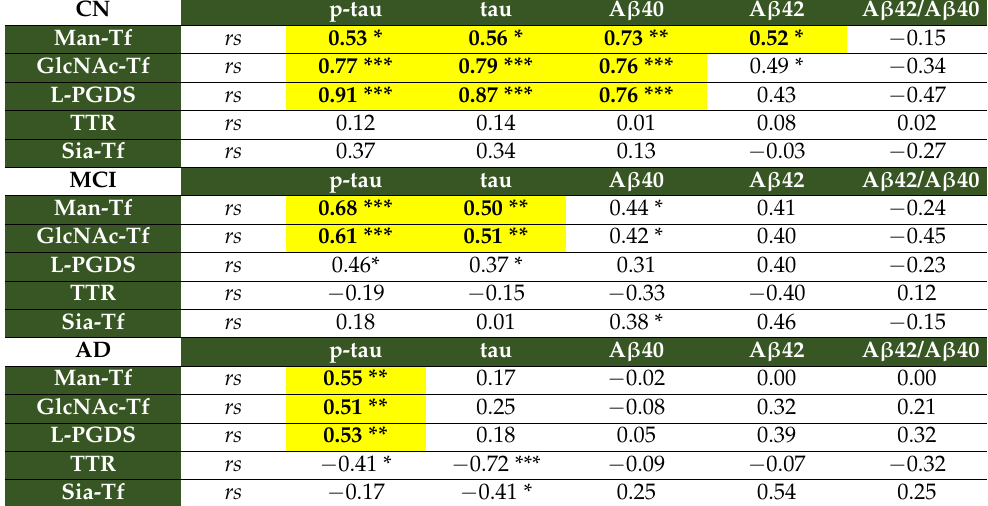
Table 2. Correlation coefficients among CSF major proteins and AD biomarkers in CN, MCI and AD. CN p-tau tau A β 40 A β 42 A β 42/A β 40 Man-Tf